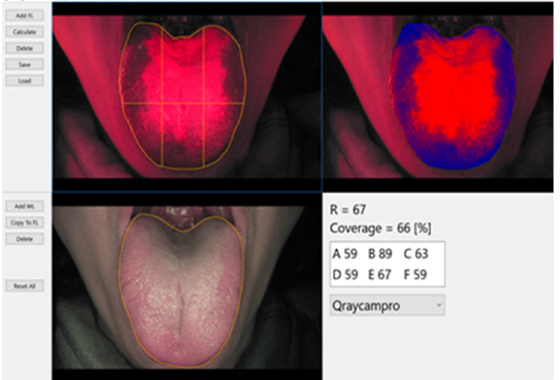
Figure 3. Evaluation of tongue coating distribution and bacterial activity using TB TB01 1.05 analysis program.